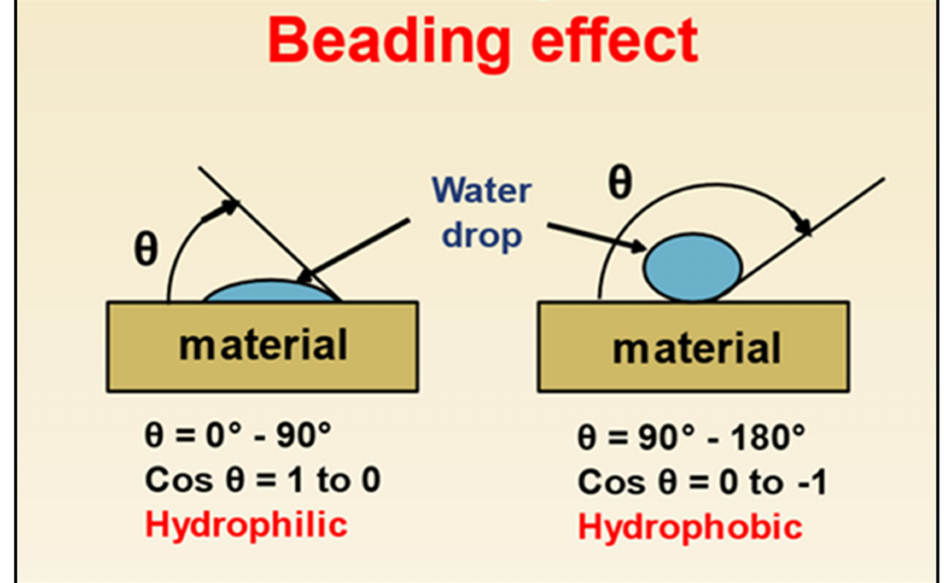
Figure 16. Ref. [12]: Illustration of the effect of hydrophilic versus hydrophobic